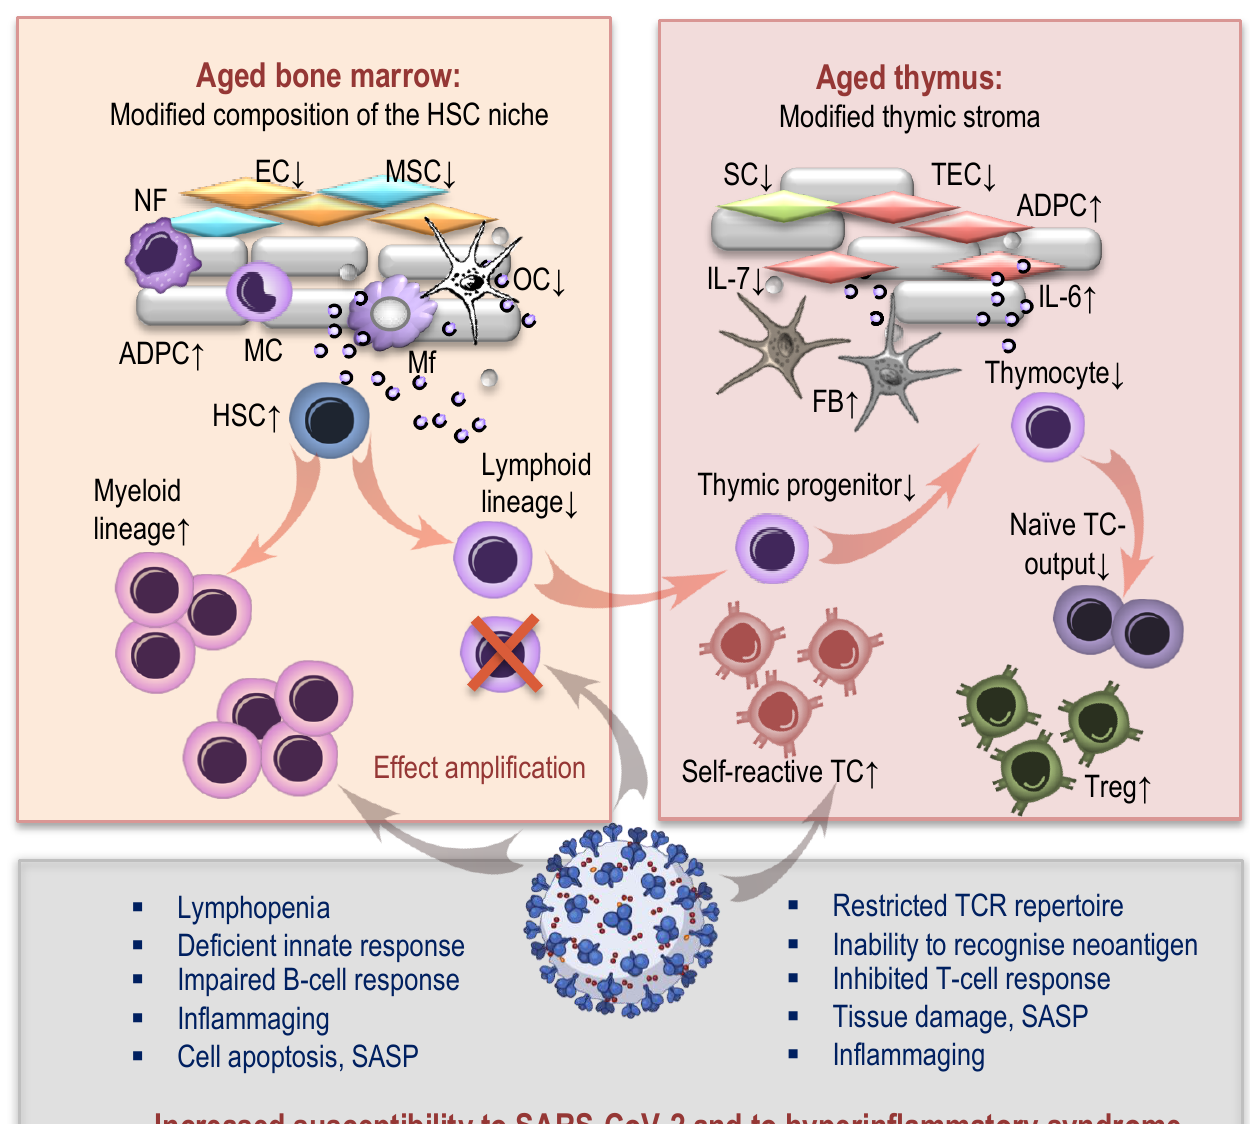
Figure 2. Age-related changes in hematopoiesis and thymopoiesis and their impacts on SARS-CoV-2 infection. NF: neutrophile; EC: endothelial cell; MSC: mesenchymal stromal cell; OC: osteoclast; ADPC: adipocyte; Mf: macrophage; MC: monocyte; HSC: hematopoietic stem cell; SC: stromal cell; TEC: thymic epithelial cell; IL: interleukin; TCR: T-cell receptor; Treg: regulatory T-cell; SASP: senescence-associated secretory phenotype; TC: T-cell.